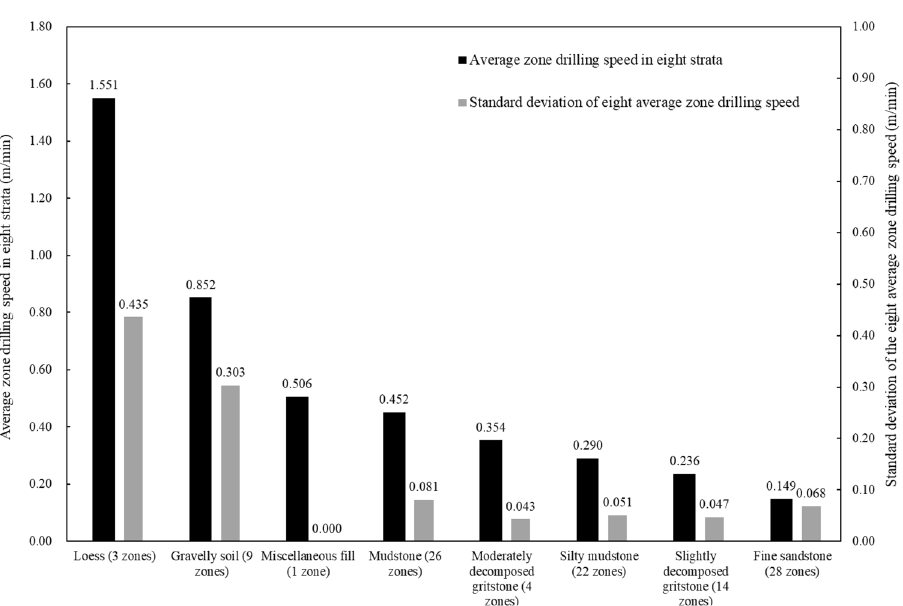
Figure 7. The average zone drilling speed and corresponding standard deviation of eight strata in the